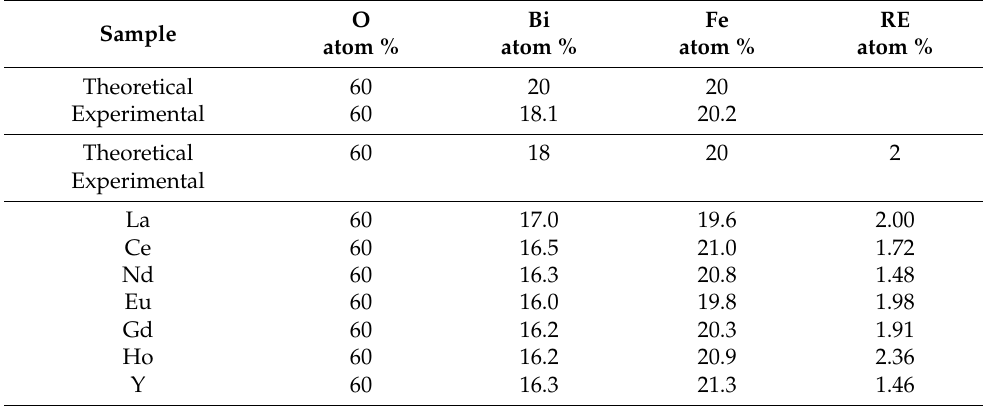
Table 1. Chemical composition of the samples. The values were normalized toward the theoretical content of